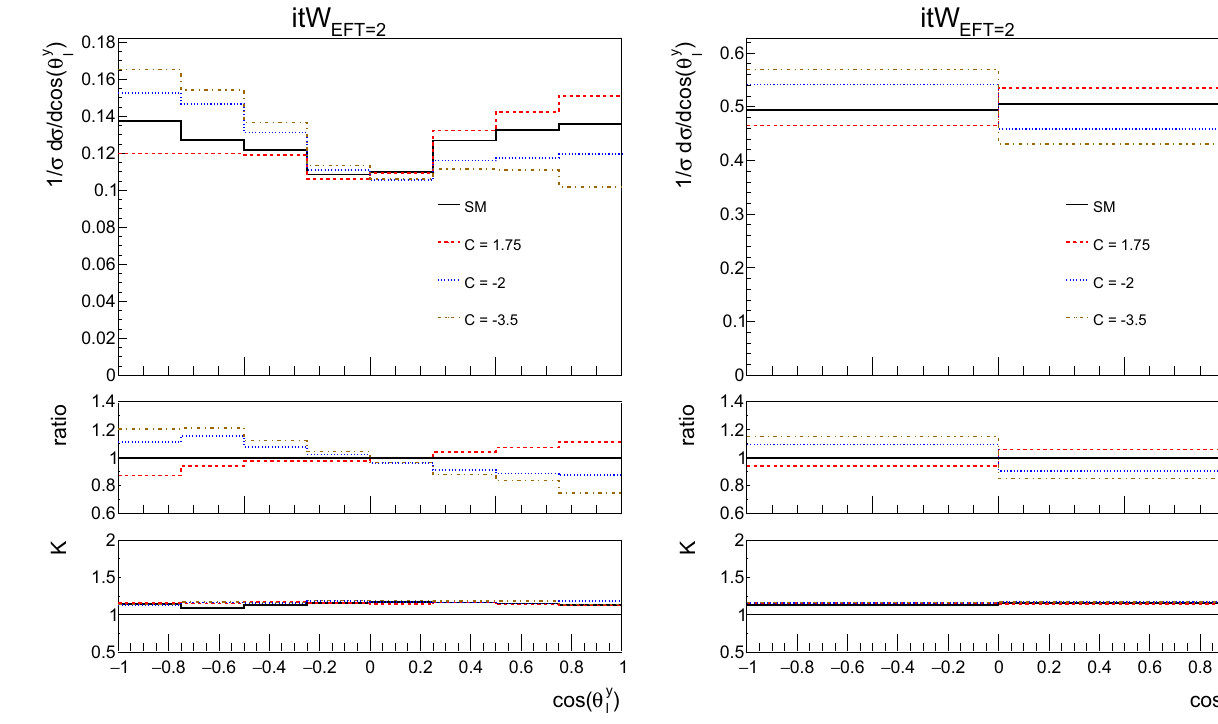
ratio shown in the first inset is defined as the effect of the operator over the SM, the second inset shows the K -factor. Here additional cuts are > 10GeVand | η l | < 2 . 47andjets: p j > 20 appliedontheleptons: p l T T GeV and | η j | < 4 .